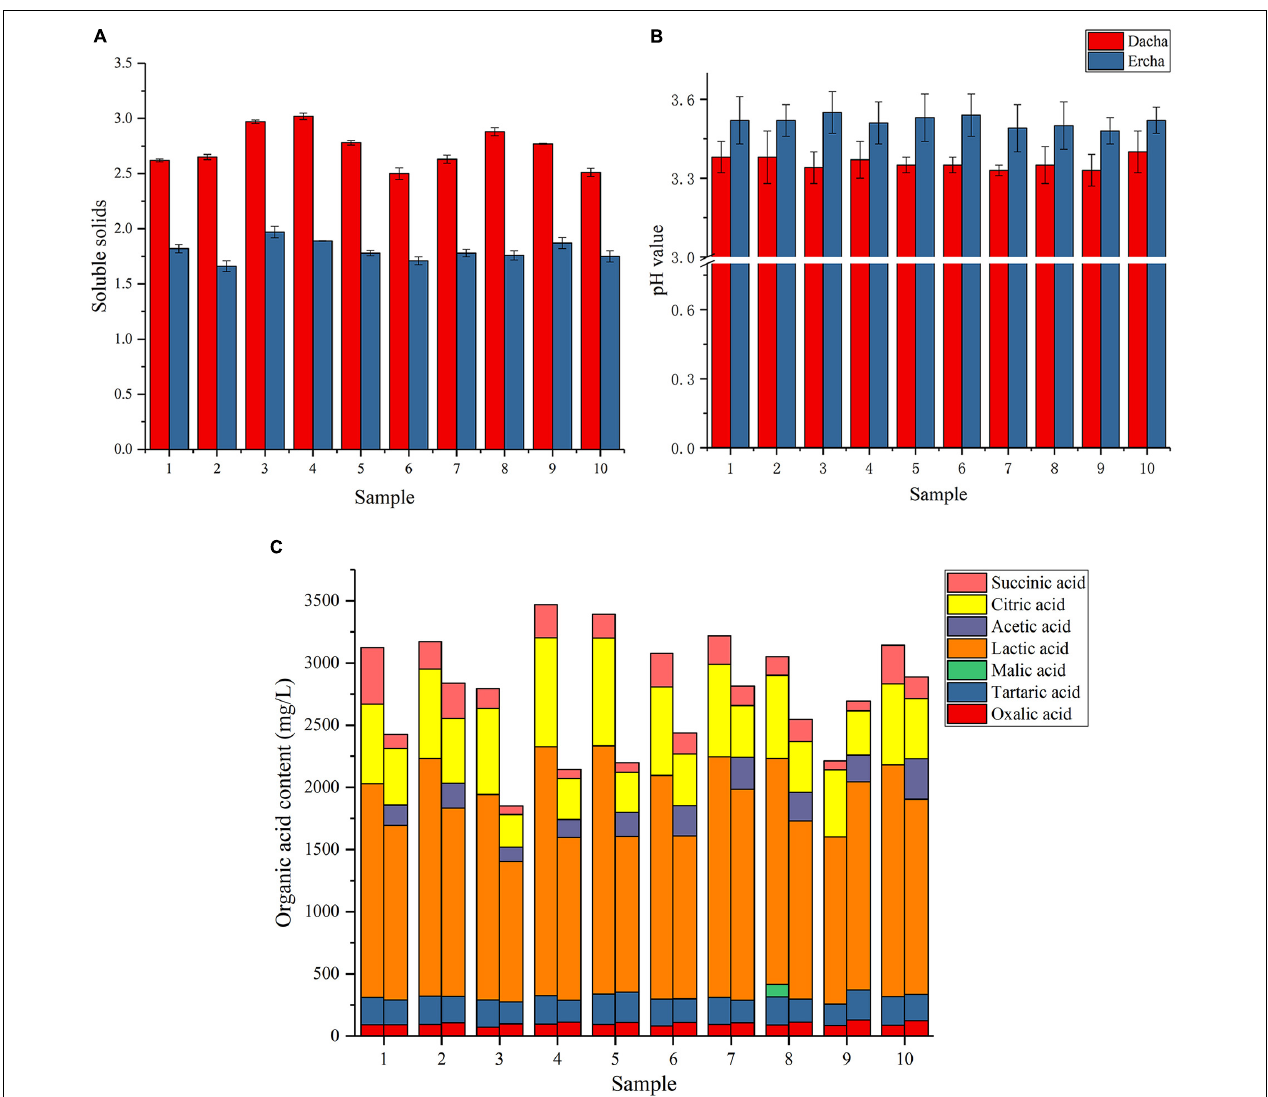
FIGURE 1 | Soluble solid content (A) , pH value (B) , and organic acid content (C) of fermented